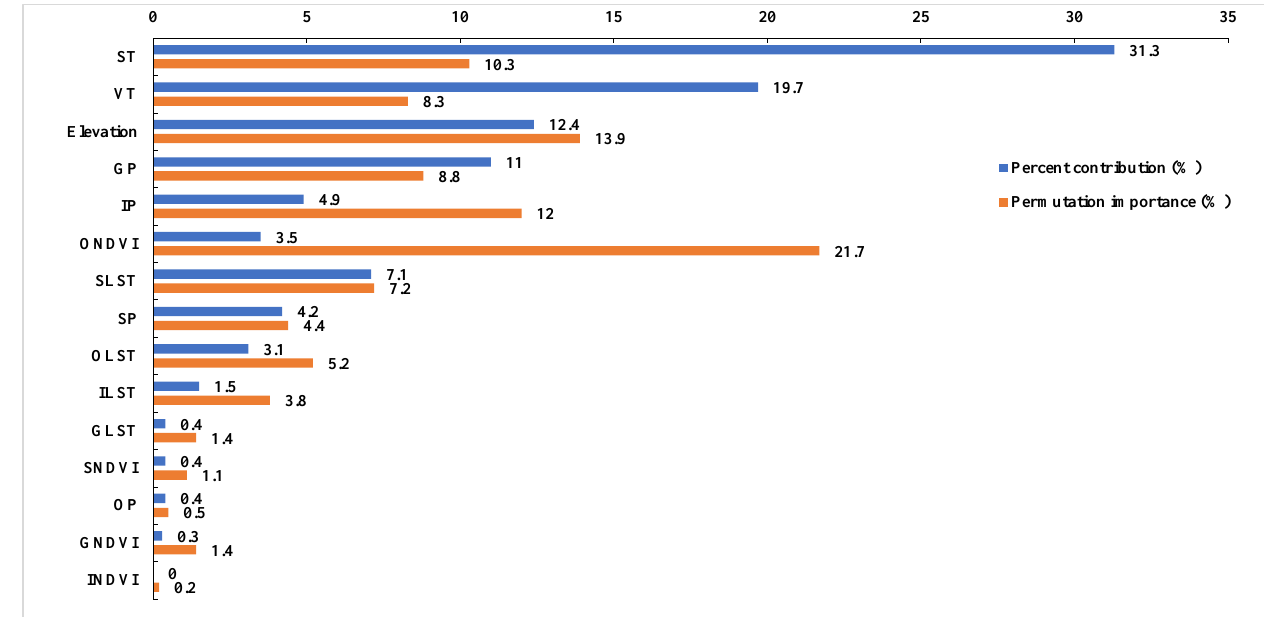
Figure 5. Relative percent contribution and permutation importance of habitat factors.